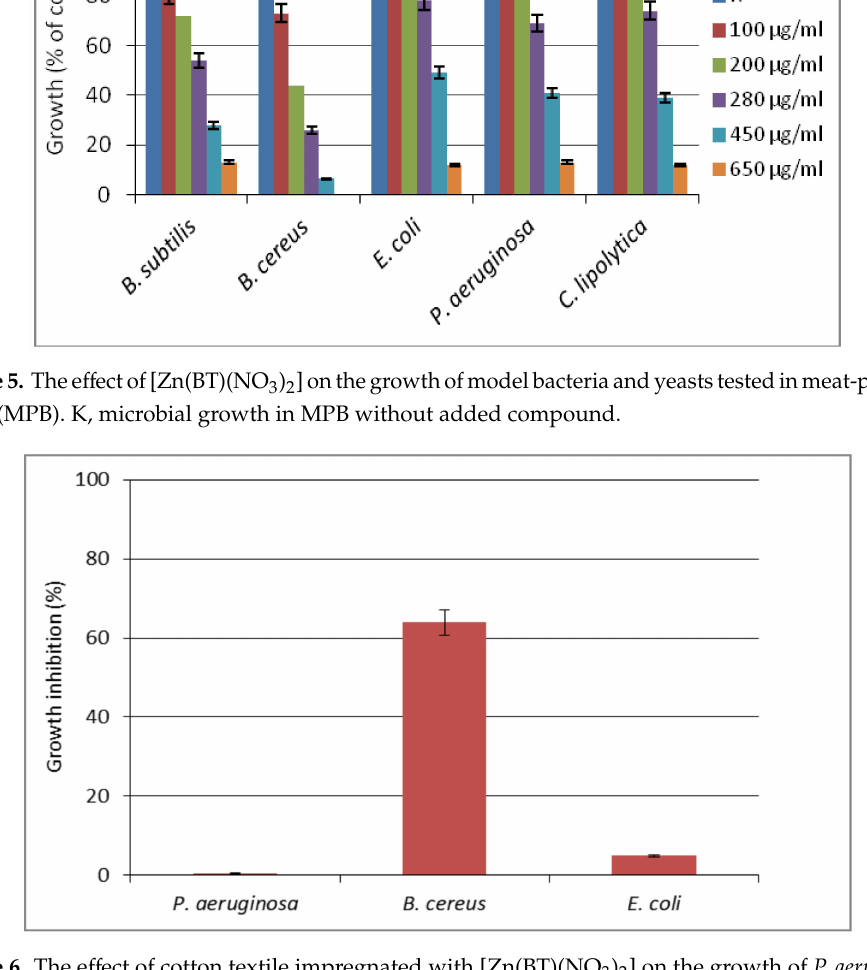
Figure 6. The e ff ect of cotton textile impregnated with [Zn(BT)(NO 3 ) 2 ] on the growth of P. aeruginosa, B. cereus and E. coli tested in